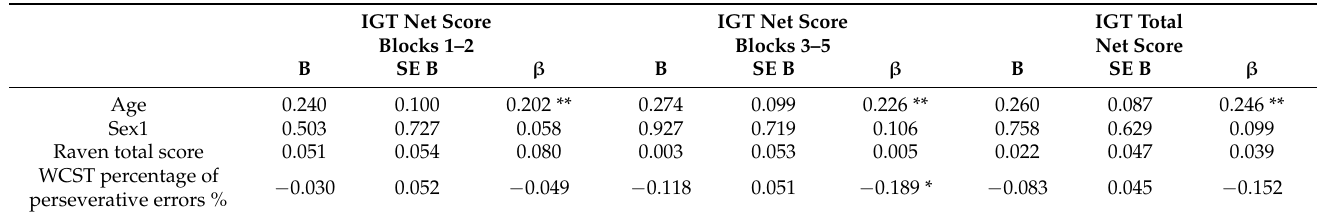
Table 3. Summary of regression analysis for variables predicting net score. Net Score Blocks 1–2, Net Score Blocks 3–5 and Net Score Total on the Iowa Gambling Task (N =